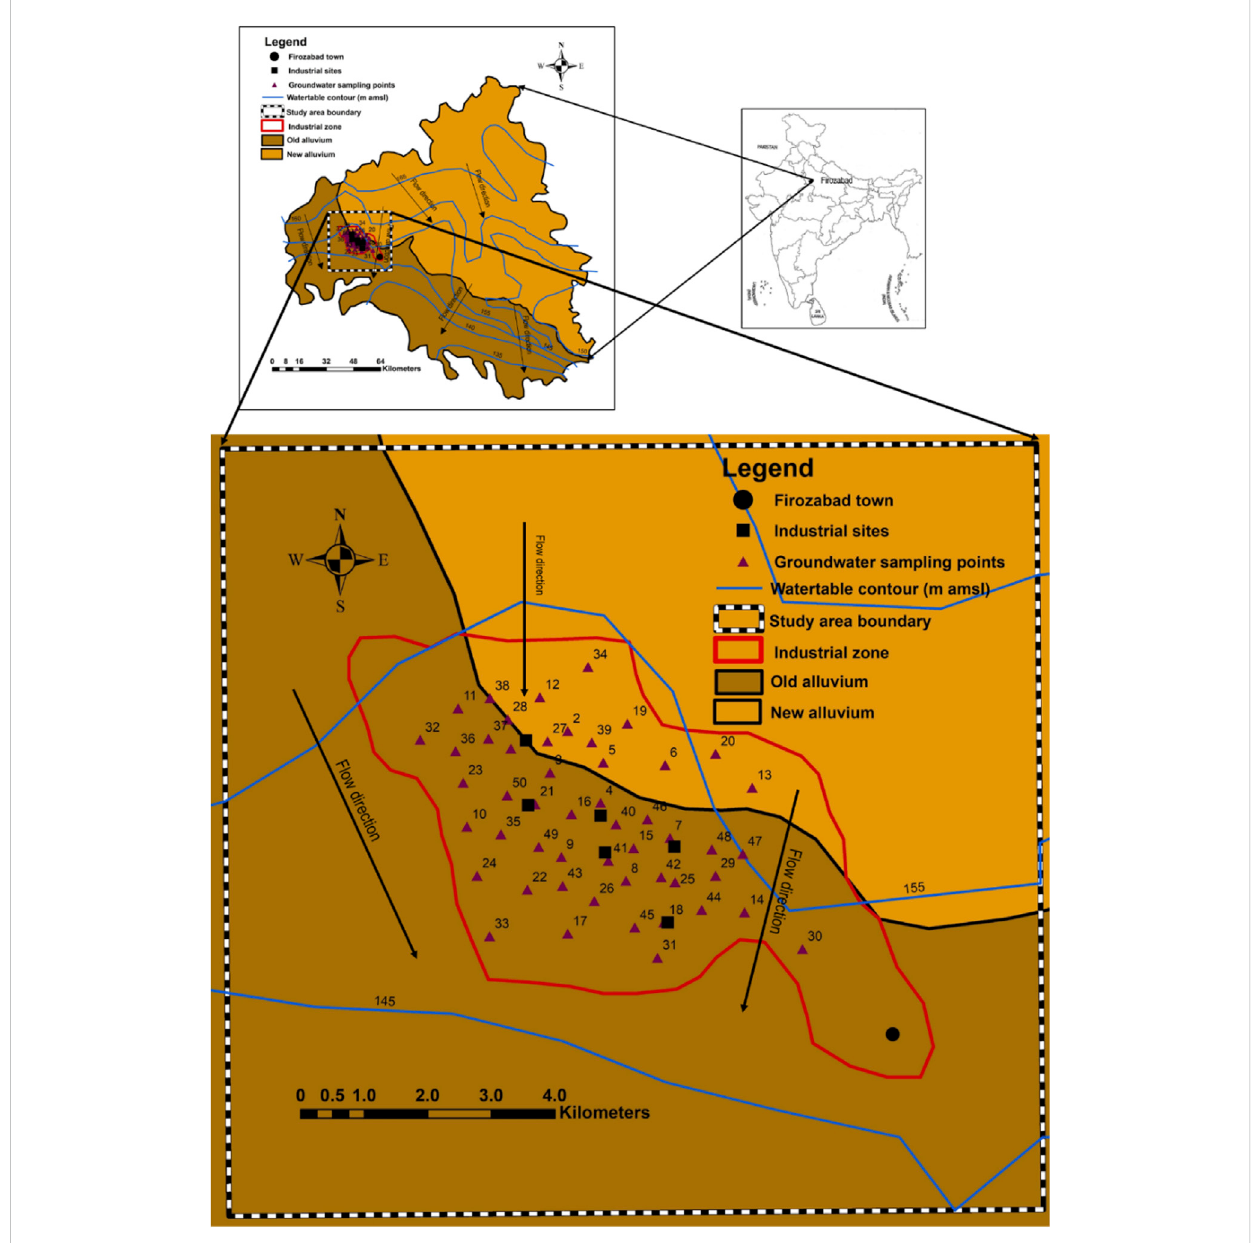
FIGURE 1 Map showing the sampling location, geology, hydrogeology and groundwater fl ow direction in the study